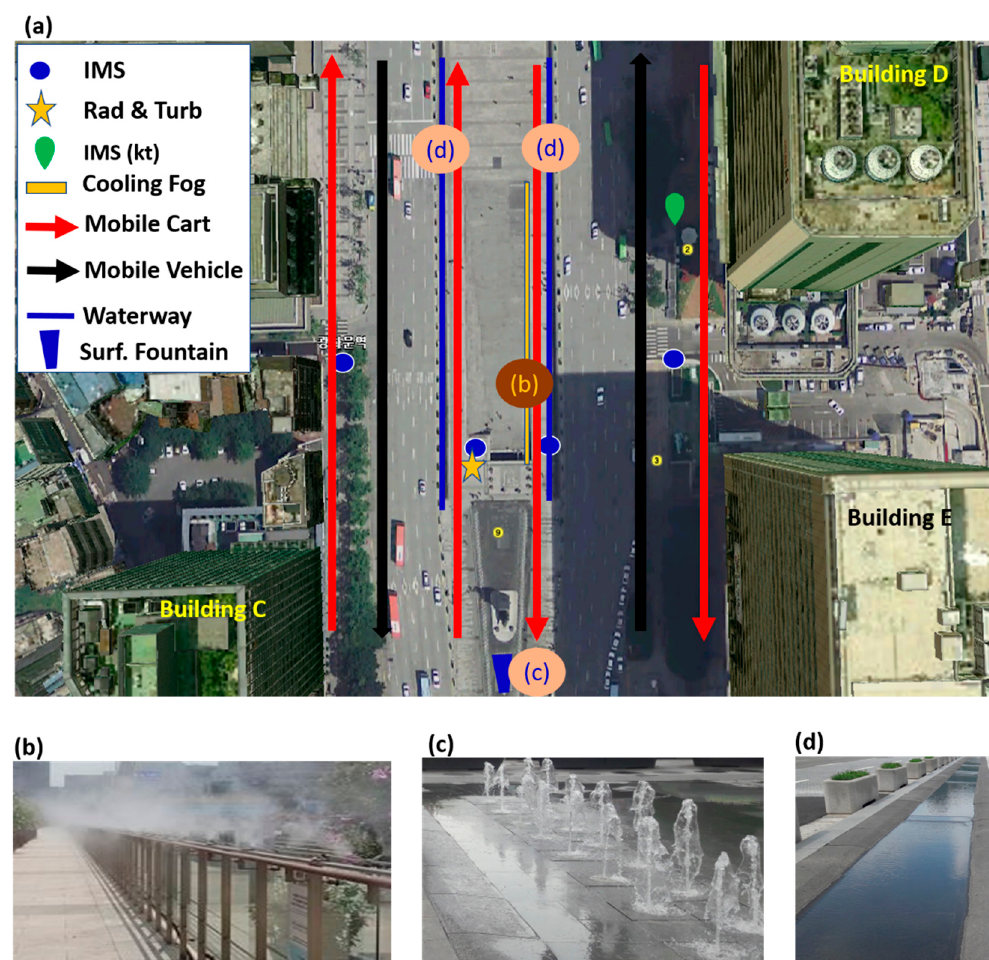
Figure 2. ( a ) Detailed location of fixed instruments or sensors and moving routes of mobile vehicle and cart with cooling fog measurement system, historic waterway, and surface fountain during the building-block urban meteorological observation experiment (BBMEX), ( b ) cooling fog, ( c ) surface fountain, and ( d ) historic waterway.